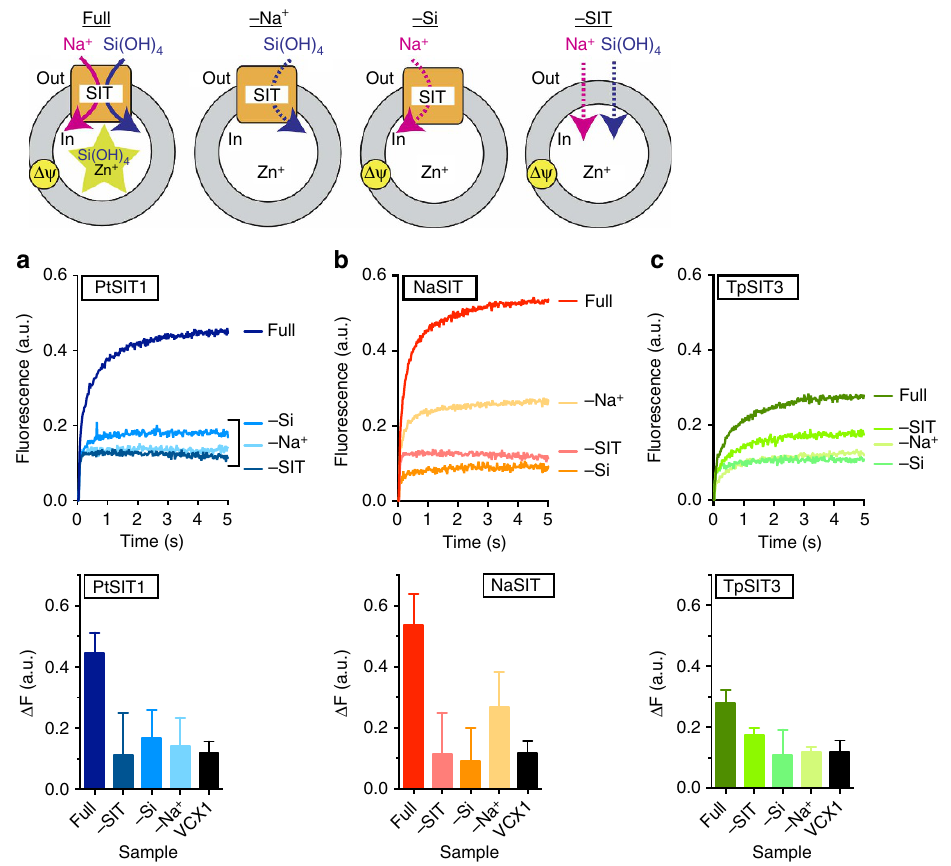
Figure 4 | Silicic acid transport into energized Zn-loaded proteoliposomes. Averaged raw data are shown from experiments with ( a ) PtSIT1, ( b ) NaSIT and ( c ) TpSIT3. The lower panels show the mean fluorescence change ± s.d. from eight technical